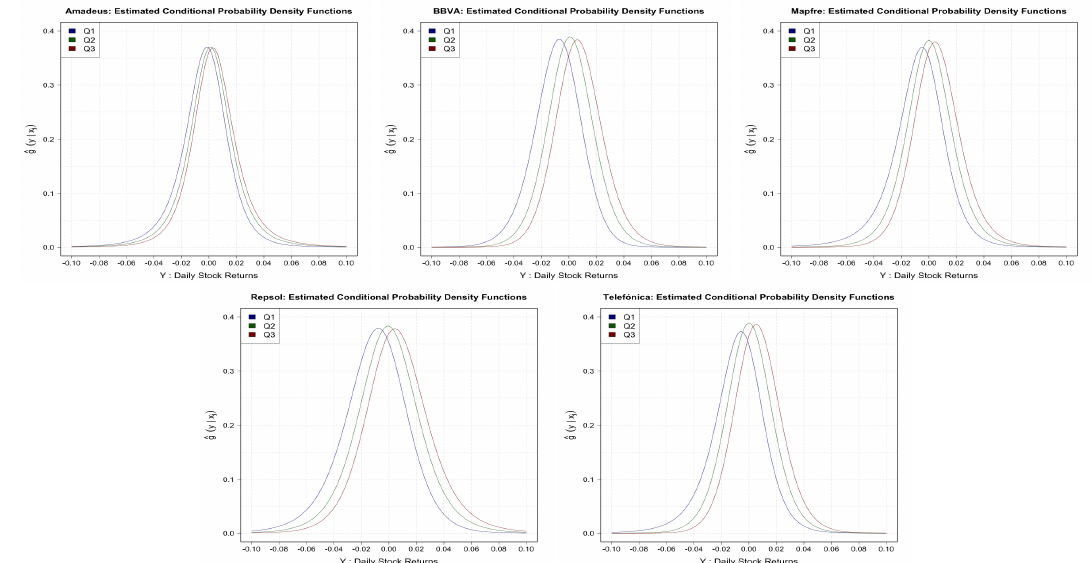
Figure 4. Conditional densities of stock returns at the quantiles of IBEX35 for Amadeus ( upper left ), BBVA ( upper center ), Mapfre ( upper right ), Repsol ( lower left ), and Telefónica ( lower right ).